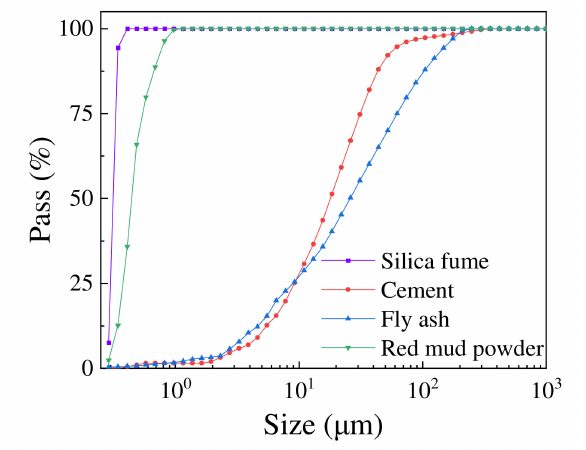
Figure 2. Particle size compositions of cement and